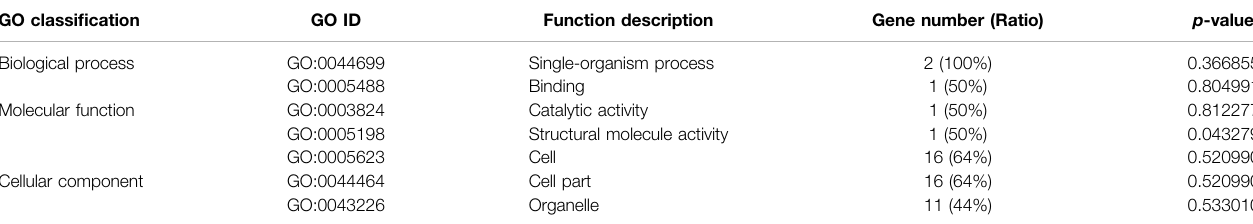
TABLE 6 | GO enrichment for strong positive select genes by comparing Zeugodacus cucurbitae (Coquillett) and Bactrocera dorsalis